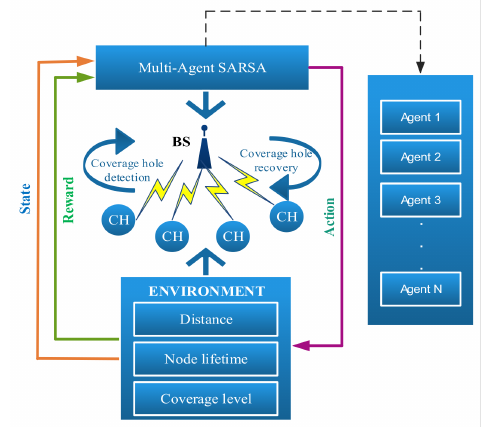
Figure 3. Coverage hole detection and